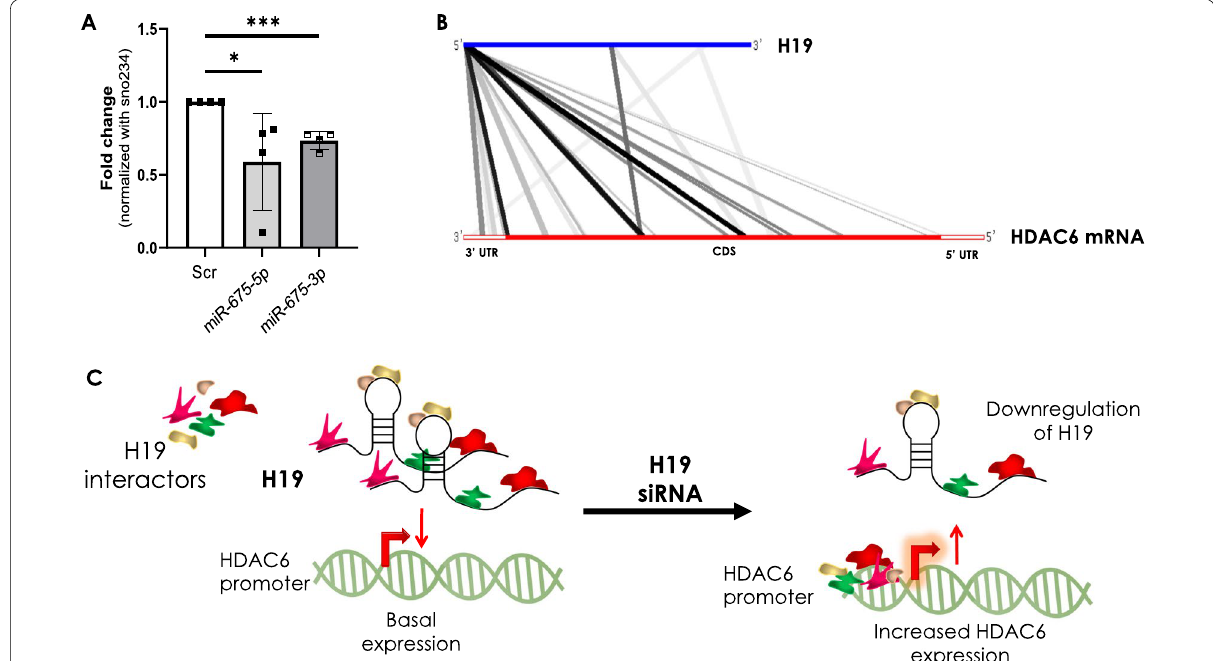
Fig. 3 Schematic representation of potential regulatory mechanisms of HDAC6 by lncRNA H19. A Differentiated C2C12 cells were transfected with either the scramble or H19 siRNA (5 nM) and after 48 h, total RNA was isolated and the levels of miR-675-5p and miR-675-3p were assessed by qRT-PCR. Sno-234 was used as the loading control. Data are means of at least three independent experiments and values are means *p 0.05, ***p 0.001. B Potential binding between the lncRNA H19 and HDAC6 mRNA as derived from the online LncRRIsearch prediction tool. ≤ ≤ UTR: Untranslated Region; CDS: Coding DNA sequence. C Binding of H19 to its interactors might prevent their occupancy on the HDAC6 promoter, thereby preventing its transcription. In the absence or decreased levels of H19, the interactors get free to bind to their potential binding elements on the HDAC6 promoter to increase HDAC6 gene